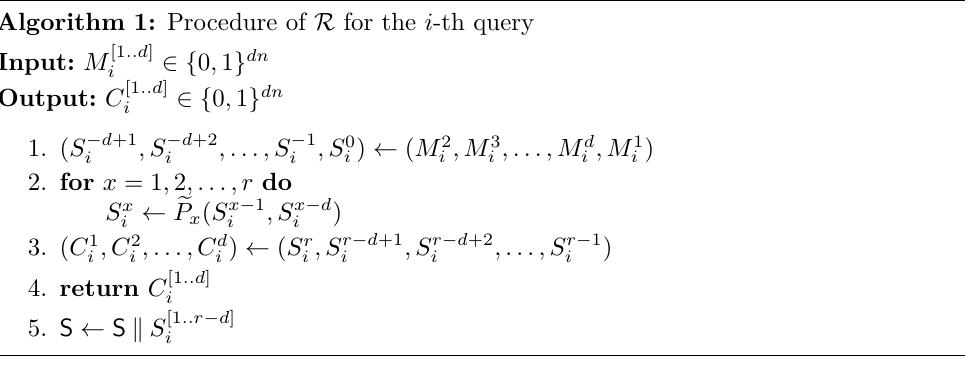
Algorithm 2: Procedure of I for the i -th query